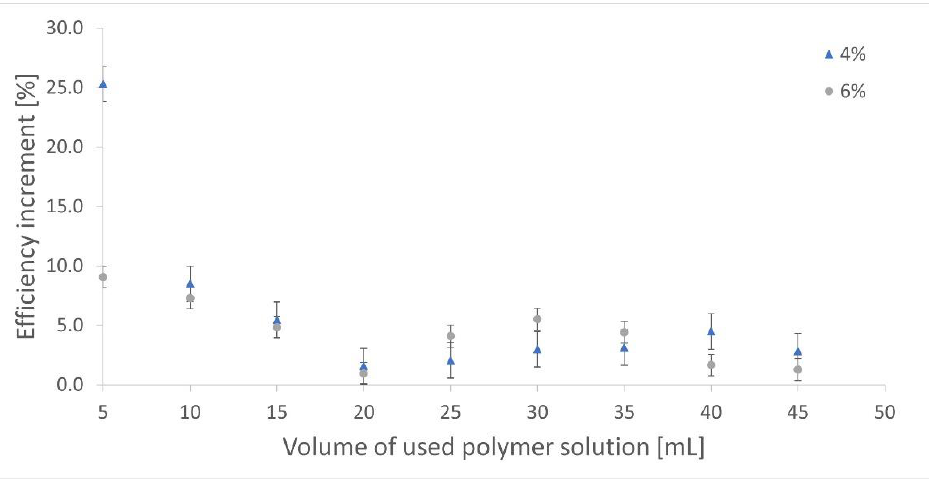
Figure 12. Overall filtration efficiency increments as a function of the polymer solution’s volume.